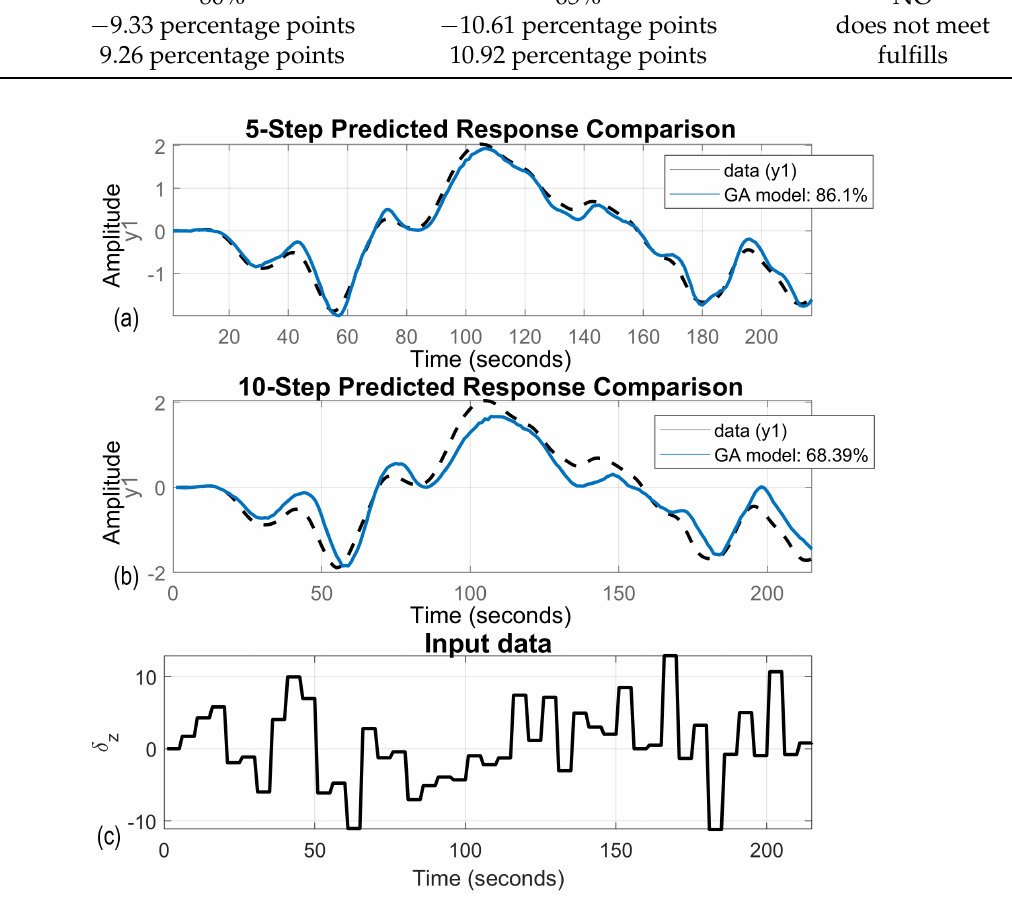
Figure 7. Examples of regularized GA model prediction based on real-time lake validation data;